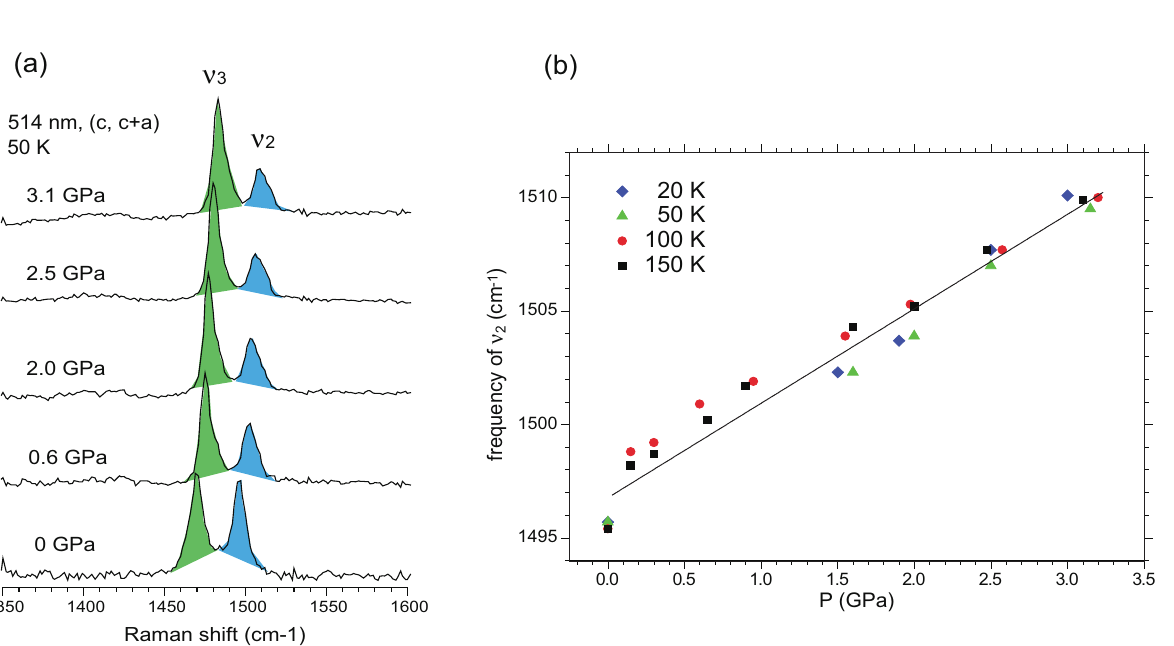
Figure 23. ( a ) Pressure dependence of the Raman spectrum of θ -(BEDT-TTF)